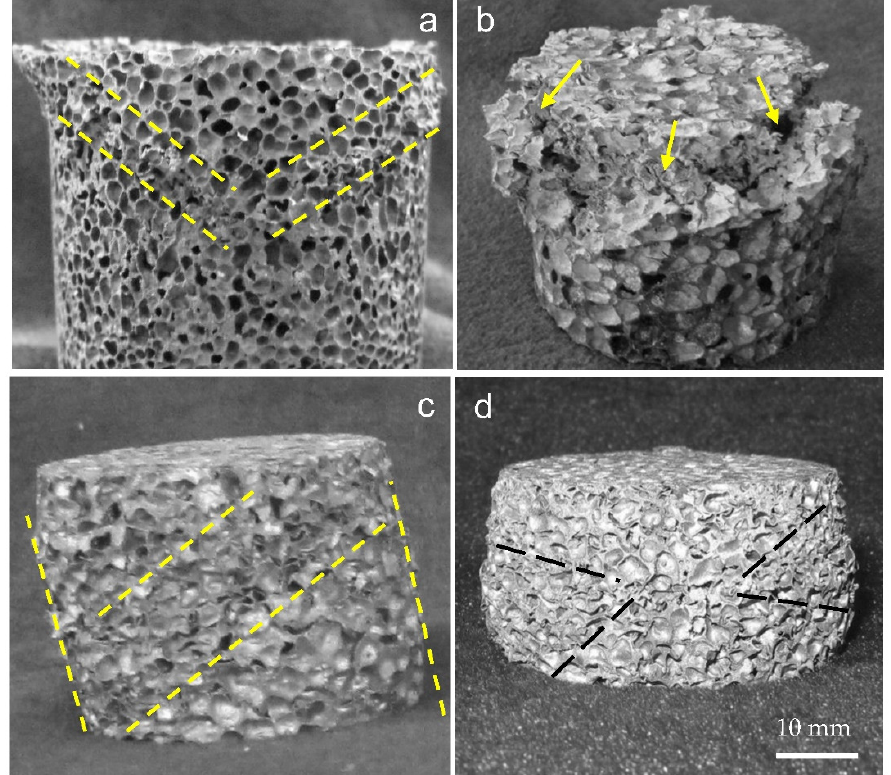
Figure 12. Uniaxial impact failure modes ( a ) “V”-shaped deformation mode ( b ) end crack damage ( c ) shear failure mode ( d ) localized buckling failure mode.